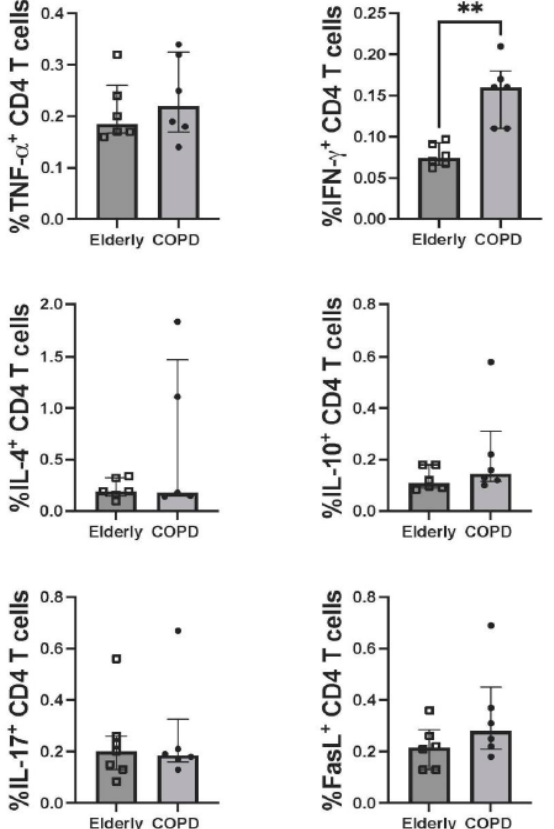
Figure 2. CD4 T-cell responses to pooled peptides of SARS-CoV-2 wild-type spike proteins. Note: PBMCs obtained from COPD (N = 6) and healthy elderly ( n = 6) at 4 weeks after ChAdOx-1/ChAdOx-1 homologous vaccination were stimulated with pooled peptides of the wild-type spike protein (all functional domains) and analyzed for the expression of molecules of interest using immunofluorescence staining and flow cytometry. The graphs indicate frequency of CD4 T-cells expressing TNF- α , IFN- γ , IL-4, IL-10, IL-17A and FasL. Individual data of each study group are shown. Lines represent the median with the interquartile range. The Mann–Whitney U test was used for comparisons. **, p ≤ 0.01.